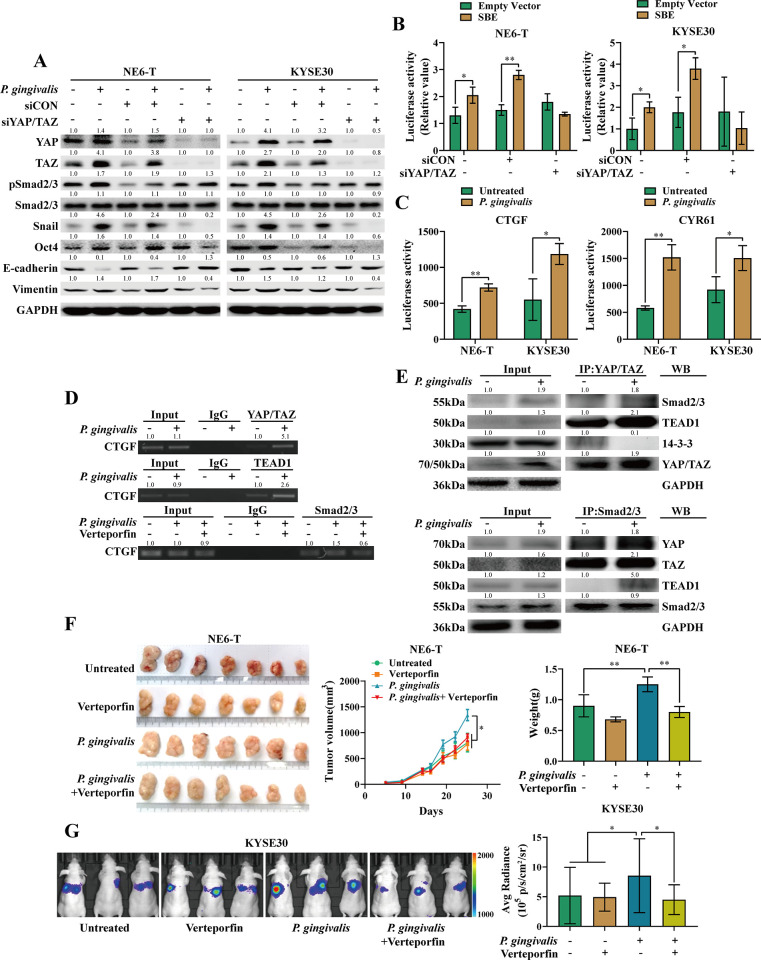
P. gingivalis induces Smads/YAP/TAZ/TEAD1 complex formation.(A) Western blots were used to detect the indicated protein levels in NE6-T and KYSE30 cells with different treatments. Representative of 3 independent experiments. (B) NE6-T and KYSE30 cells were transfected with control siRNA or siRNA targeting YAP/TAZ and treated with P. gingivalis for 24 h and dual luciferase assay of Smad reporter was performed. R. luciferase activity was normalized to firefly activity as relative luciferase activity. *P < 0.05, **P < 0.01 by Student t test. n = 3 independent experiments performed in triplicate. (C) Dual luciferase assays for YAP/TAZ transcriptional activity using pGL3 luciferase reporter vector carrying CTGF promoter or CYR61 promoter were performed in NE6-T and KYSE30 cells treated with PBS control or P. gingivalis. R. luciferase activity was normalized to firefly activity as relative luciferase activity. *P < 0.05, **P < 0.01 by Student t test. n = 3 independent experiments performed in triplicate. (D) ChIP assay was performed in NE6-T cells with different treatments using different antibodies for CTGF promoters by PCR assay with GAPDH as the internal control. (E) NE6-T cells were cocultured with PBS control or P. gingivalis, and coimmunoprecipitation was performed using different antibodies. (F) Representative data of xenograft tumors, the tumor weight (**P < 0.01 by one-way ANOVA), and the tumor growth curves (**P < 0.01 by one-way ANOVA and Bonferroni multiple comparison test) from NE6-T cells receiving different treatments. (G) Representative bioluminescence images and quantification of photon flux (*P < 0.05, Mann–Whitney U test) in different groups of mice. Results represent means ± SD. ANOVA, analysis of variance; ChIP, chromatin immunoprecipitation; CTGF, connective tissue growth factor; CYR61, cysteine-rich angiogenic inducer 61; GAPDH, glyceraldehyde-3-phosphate dehydrogenase; IP, immunoprecipitation; PBS, phosphate-buffered saline; pSmad, phosphorylated Smad; SBE, Smad-binding element; siCON, scramble control for short interfering RNA; siRNA, short interfering RNA; Smads, Drosophila mothers against decapentaplegic homologs; TAZ, Transcriptional coactivator with PDZ-binding motif; TEAD1, TEA domain transcription factor1; WB, western blot; YAP, Yes-associated protein.